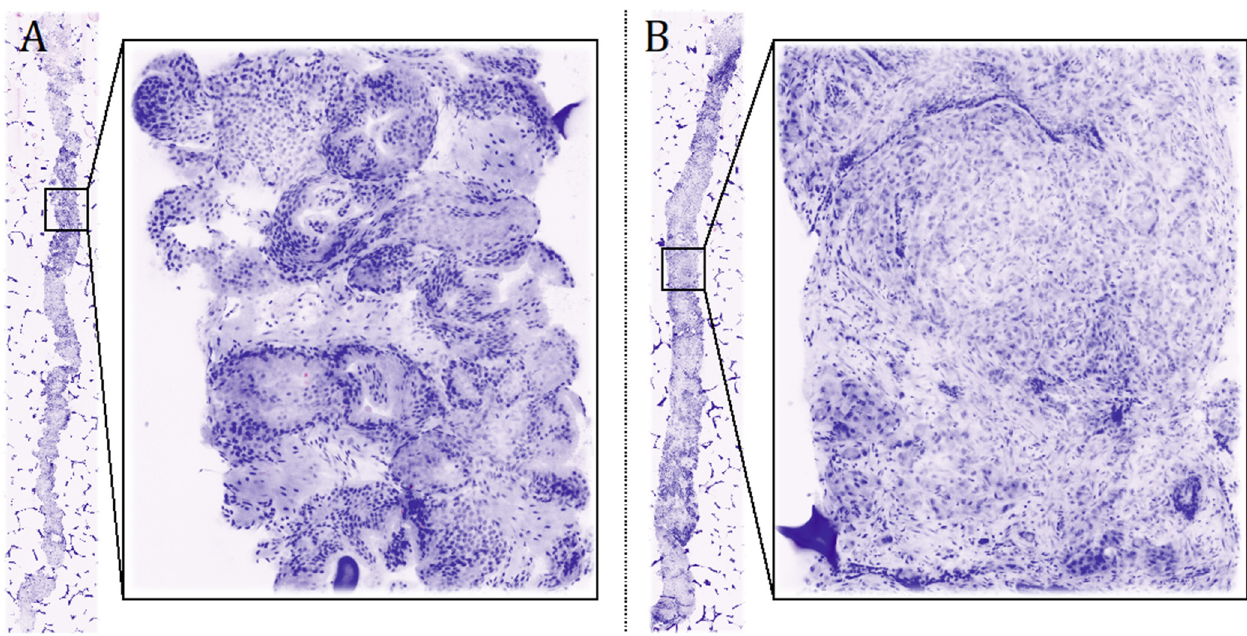
Figure 2. Digital Biopsy images. High-resolution pictures allow zooming into focal areas to better evaluate the architecture of the prostatic gland. ( A ) Negative core and zoom into normal gland architecture. ( B ) Positive core, Gleason Grade Group 4, pattern 4.